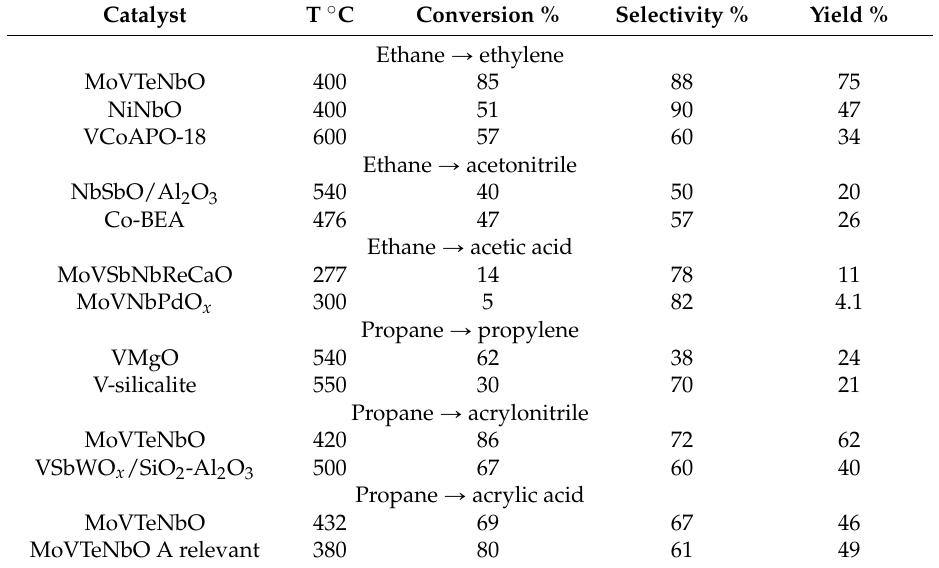
Table 2. Summary of the best results in the literature for partial oxidation of C 2 –C 3 alkanes from [3] p. 772 and references